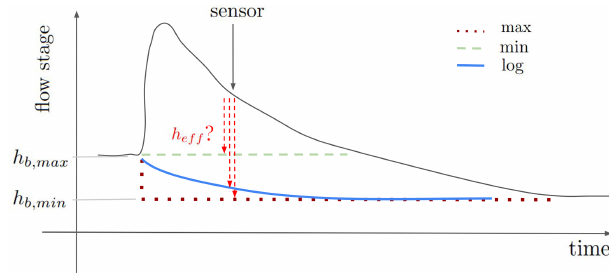
Figure 3. Assumptions about the bed level used to compute the ef- ficient flow height in a natural cross-section: assumption max maxi- mizes the effective (eff) flow height; assumption min minimizes the effective flow